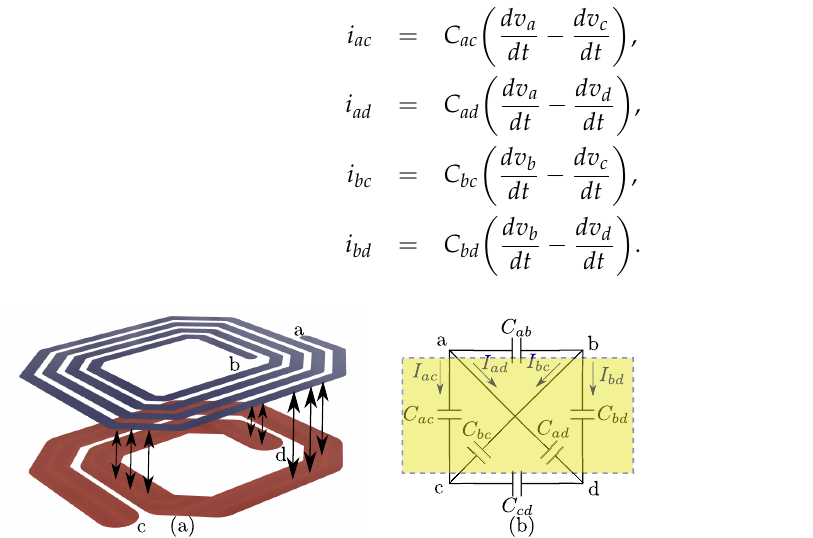
Figure 12. CM noise generation when primary and secondary layers overlap. ( a ) Physical presentation of the overlapping. ( b ) Equivalent parasitic capacitance model that shows how CM noise is